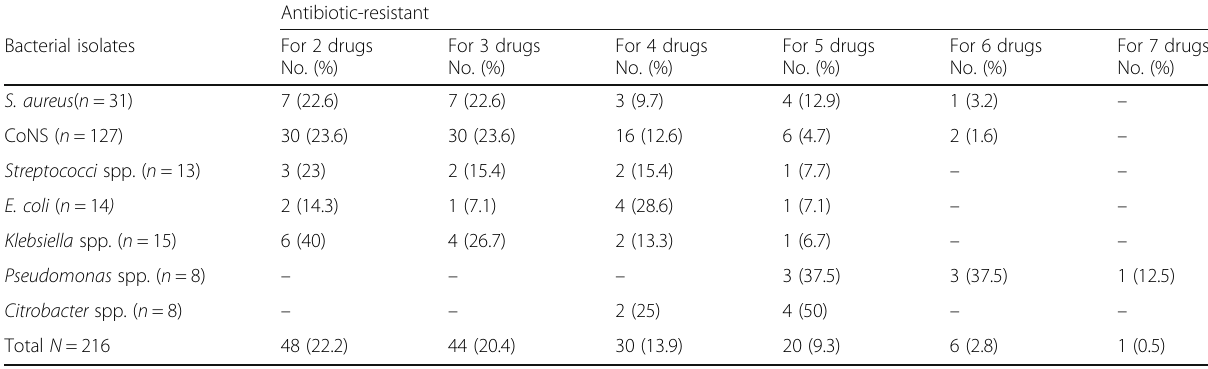
Table 5 Multiple antimicrobial resistance of bacterial isolates from the mobile phones of health professionals ( n = 226) at Hiwot Fana Specialized University Hospital, Harar, Eastern Ethiopia, Feb – Mar 2018 Antibiotic-resistant Bacterial isolates